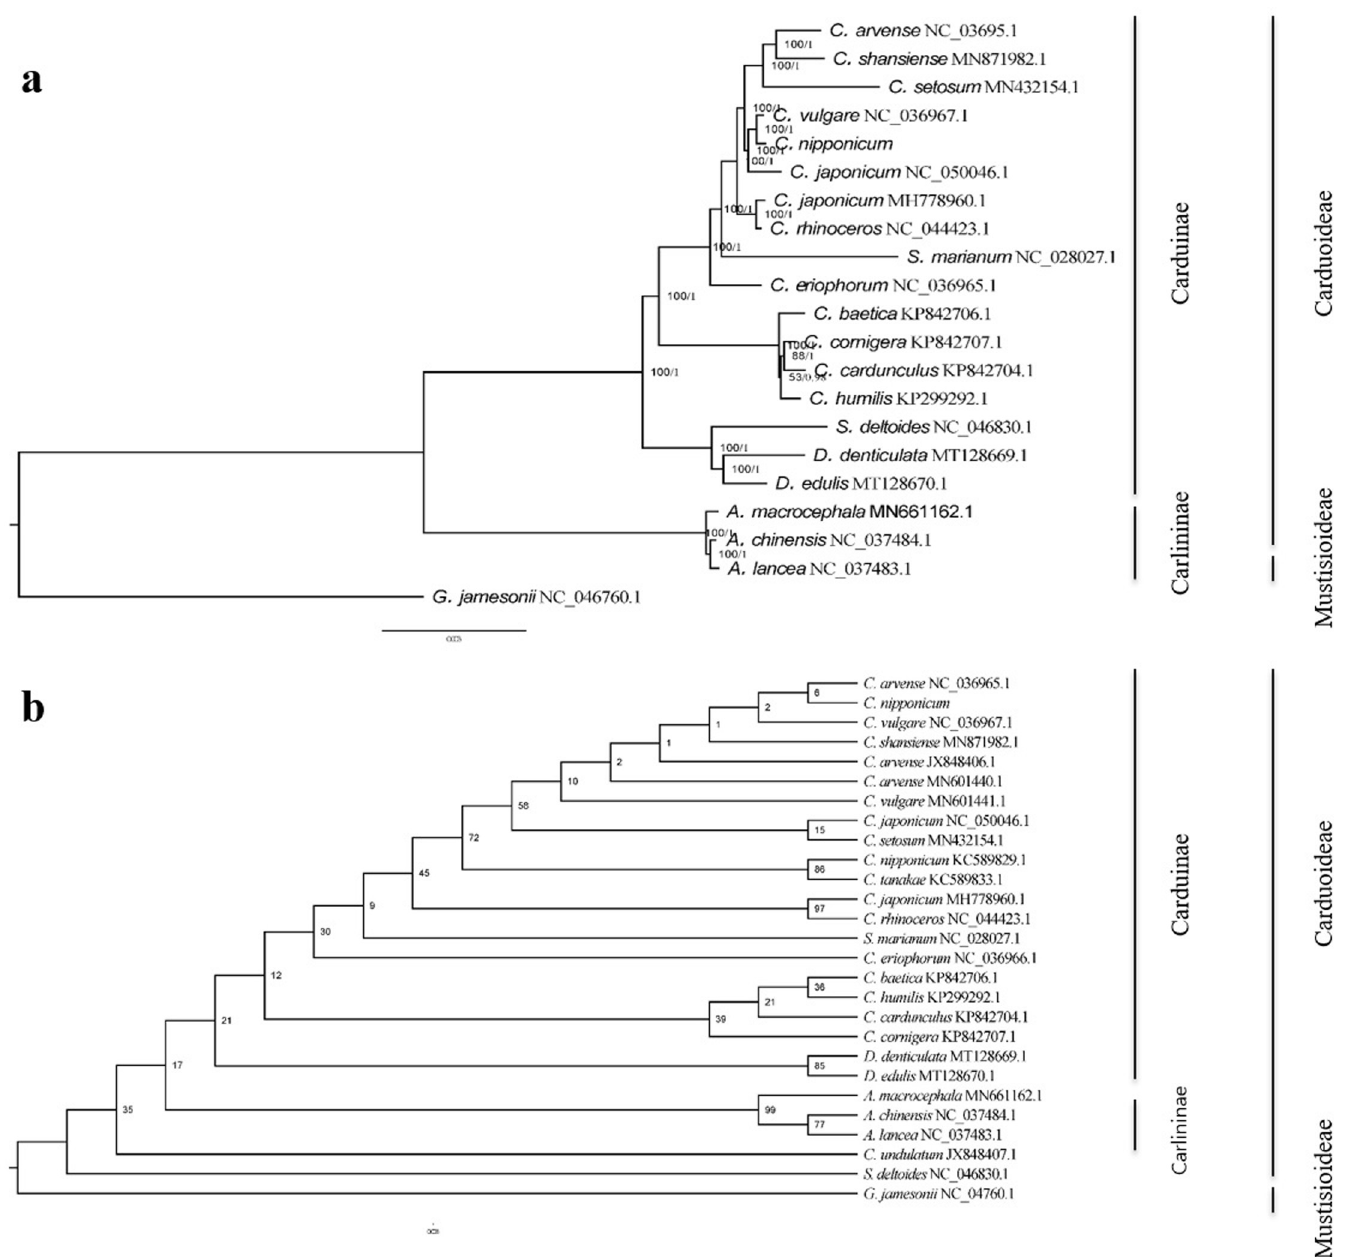
Fig 6. Phylogenetic trees based on the whole chloroplast genomes and the rbcL . (a) Phylogenetic relationship based on whole chloroplast genomes inferred by maximum likelihood (ML) with numbers beside the nodes representing the ML bootstrap values and Bayesian inference posterior probabilities; (b) Phylogenetic relationship based on the rbcL inferred by ML with numbers besides the nodes representing the ML bootstrap values.